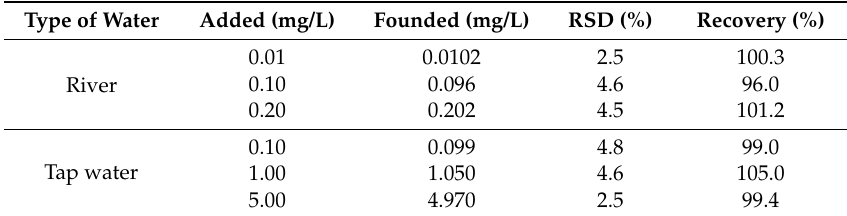
Figure 8. The anodic ECL signals spectra at the Fe 3 O 4 -NCs/GCE with different concentration BPA solutions. ( A ) The ECL spectra in the presence of different amount of BPA; ( B ) The regression equation between the ECL intensity and different BPA concentrations. Table 1. Determination of BPA in water samples (n = 3).